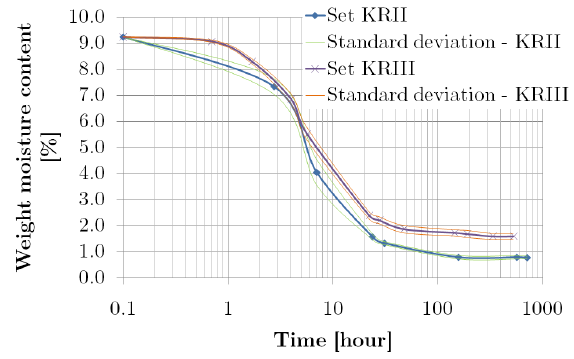
Figure 8. Time course of weight moisture content –